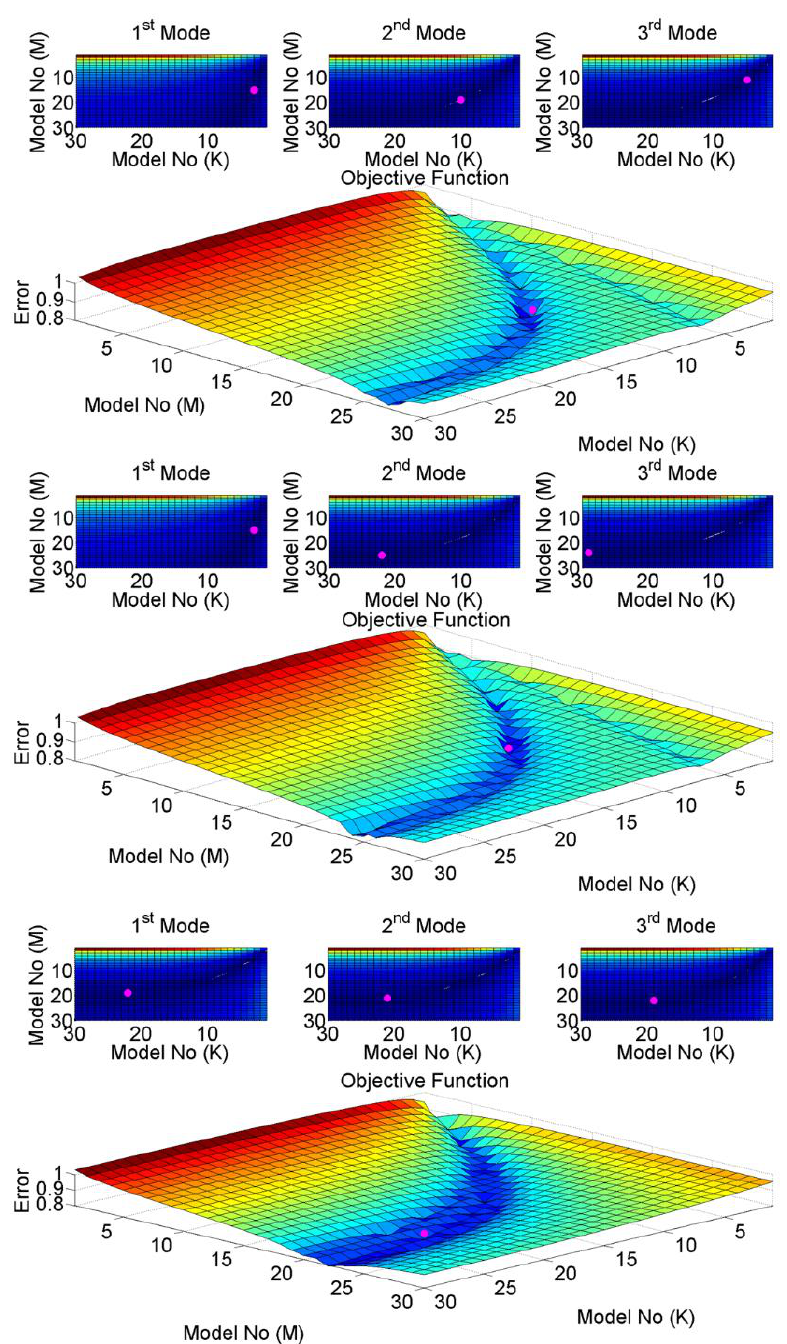
Figure 8. Modal frequency error surfaces for fixed-fixed, fixed-pinned, fixed-roller BCs.